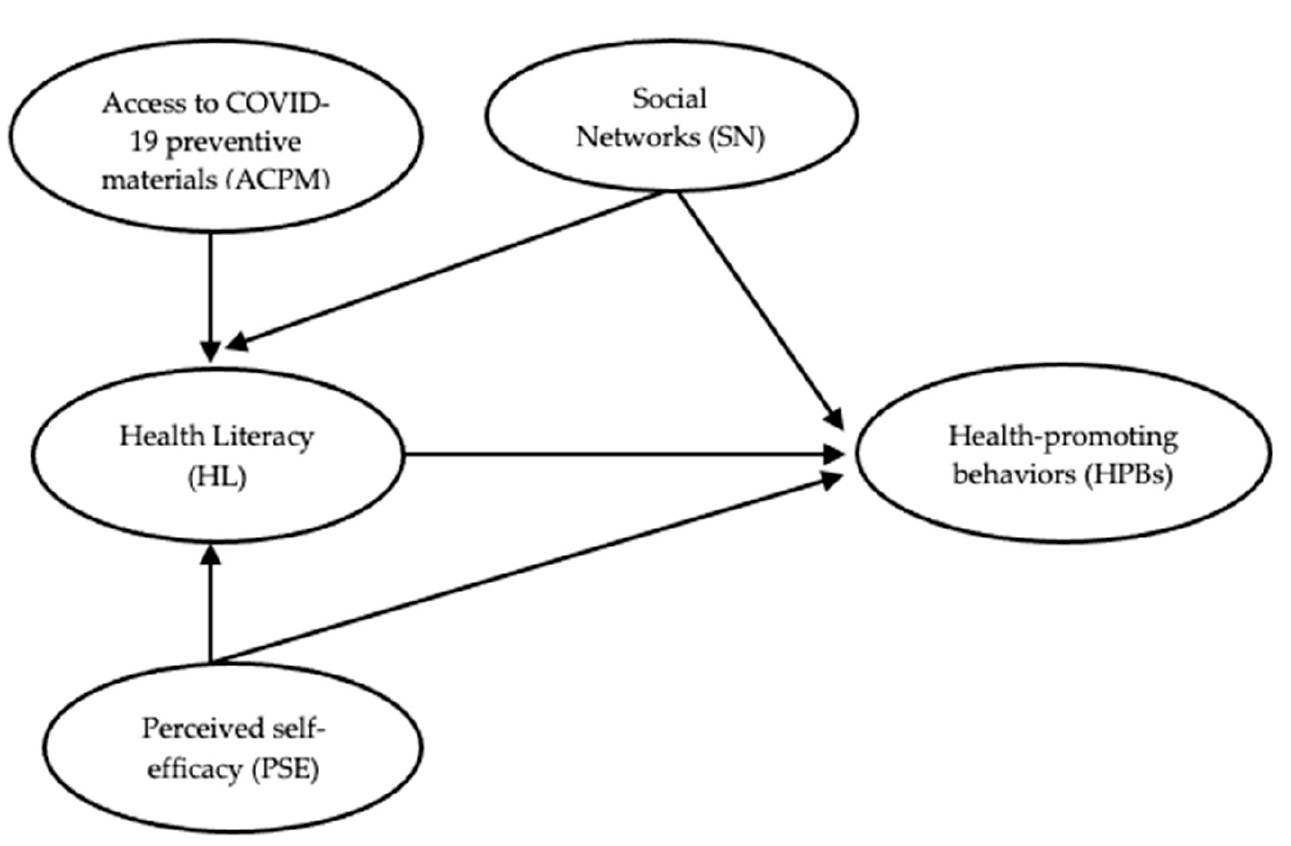
Figure 1. Research framework for the study.